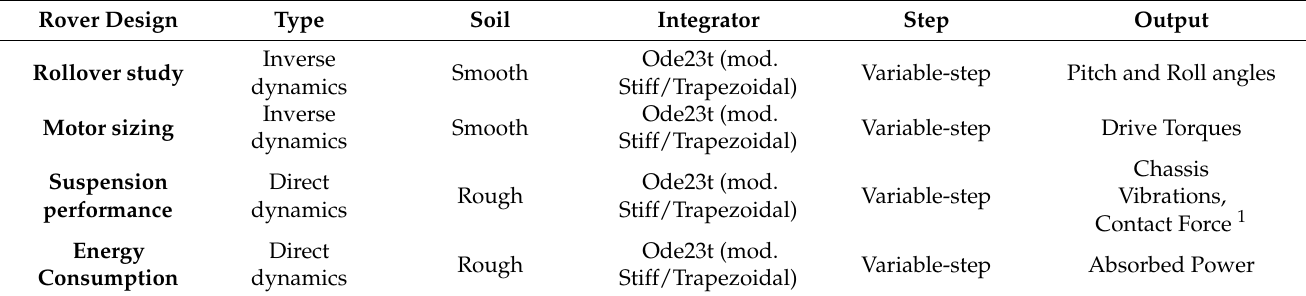
Table 1. Multibody simulation details.